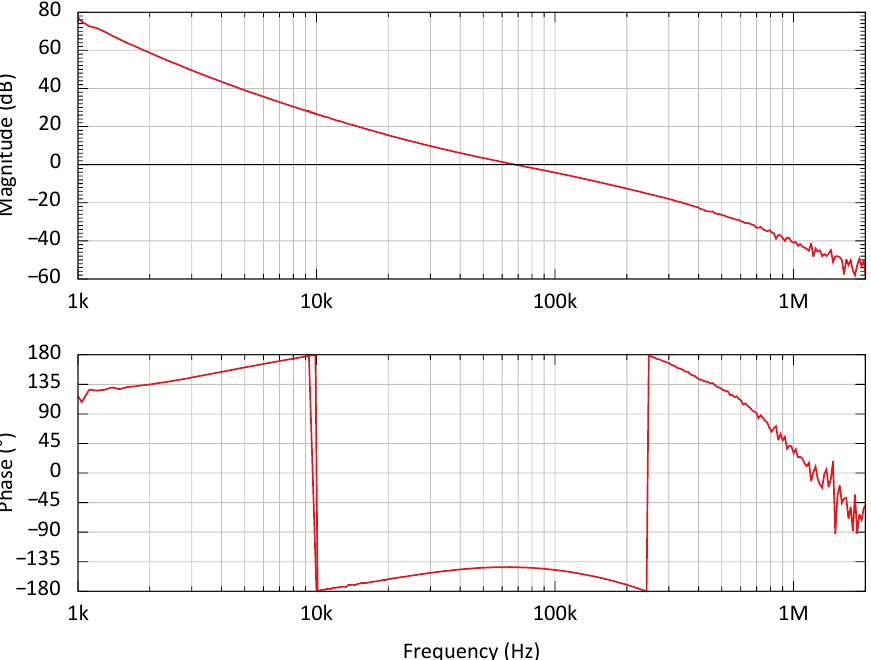
Figure 13. The open loop transfer function of the power stabilization is designed to operate with a bandwidth of 70kHz for good noise performance in the gravitational wave frequency band and for high